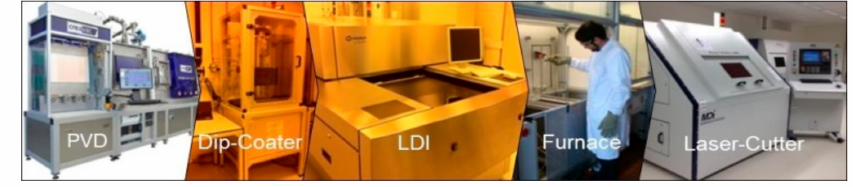
Figure 7. Fraunhofer IZM glass panel waveguide process